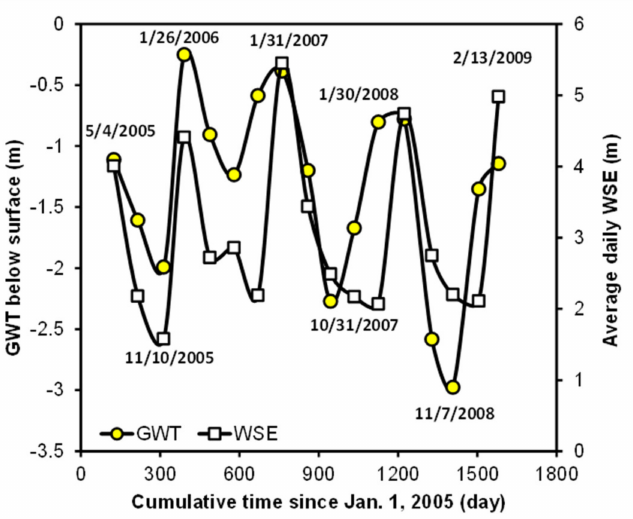
Figure 8. Variation of groundwater table and water surface elevation between 2005 and